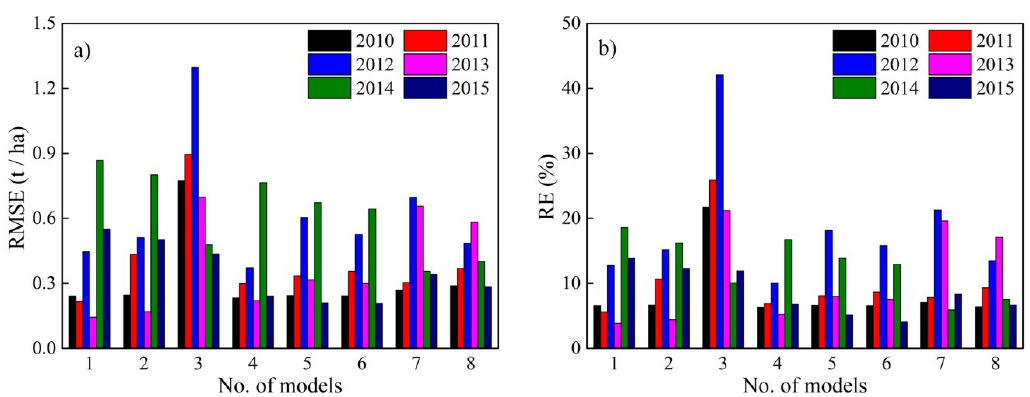
Figure 5. The RMSE ( a ) and RE ( b ) of RF models for sunflower yield estimation from 2010 to 2015.